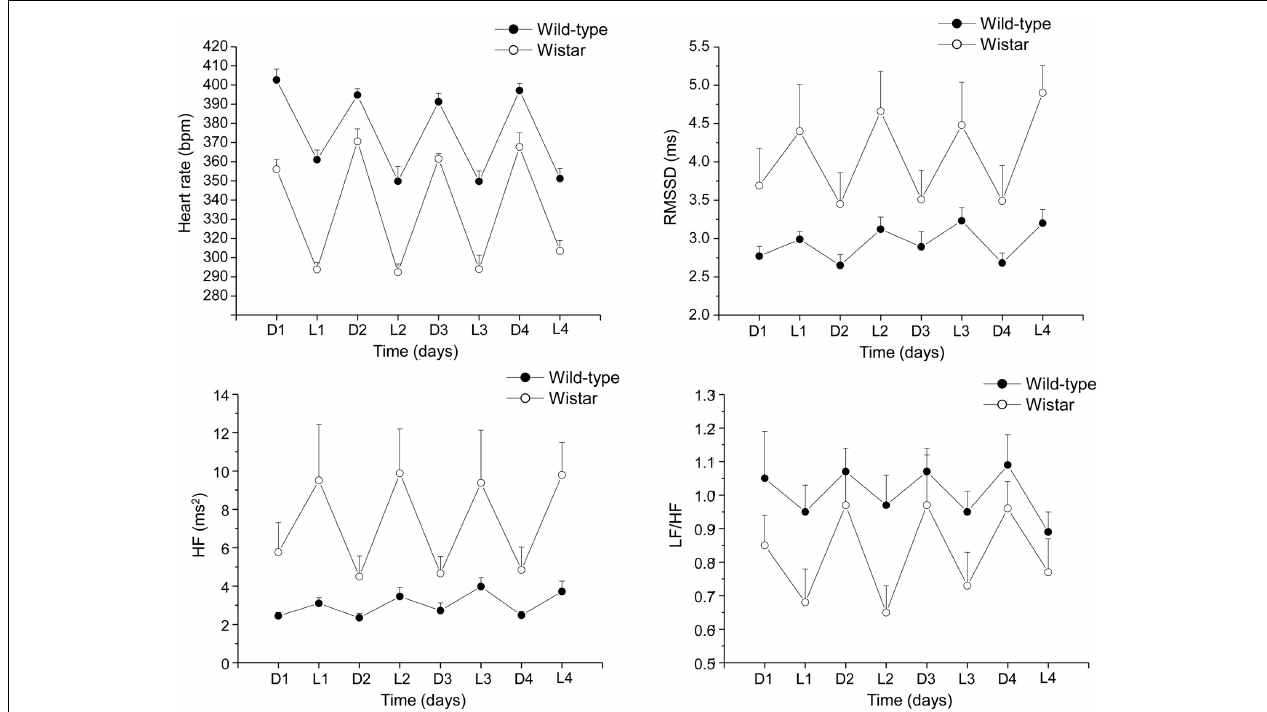
FIGURE 2 | Dailyrhythmsofheartrate,RMSSD,spectralpowerinHFband (0.75–2.5Hz) and LF (0.2–0.75Hz) to HF ratio in 4-month-old Wild-type ( n = 10) and Wistar ( n = 10) rats. These values (reported as means ± s.e.m.) wereobtainedbyaveragingmultiple2-minsegmentsacquiredeveryhourduring